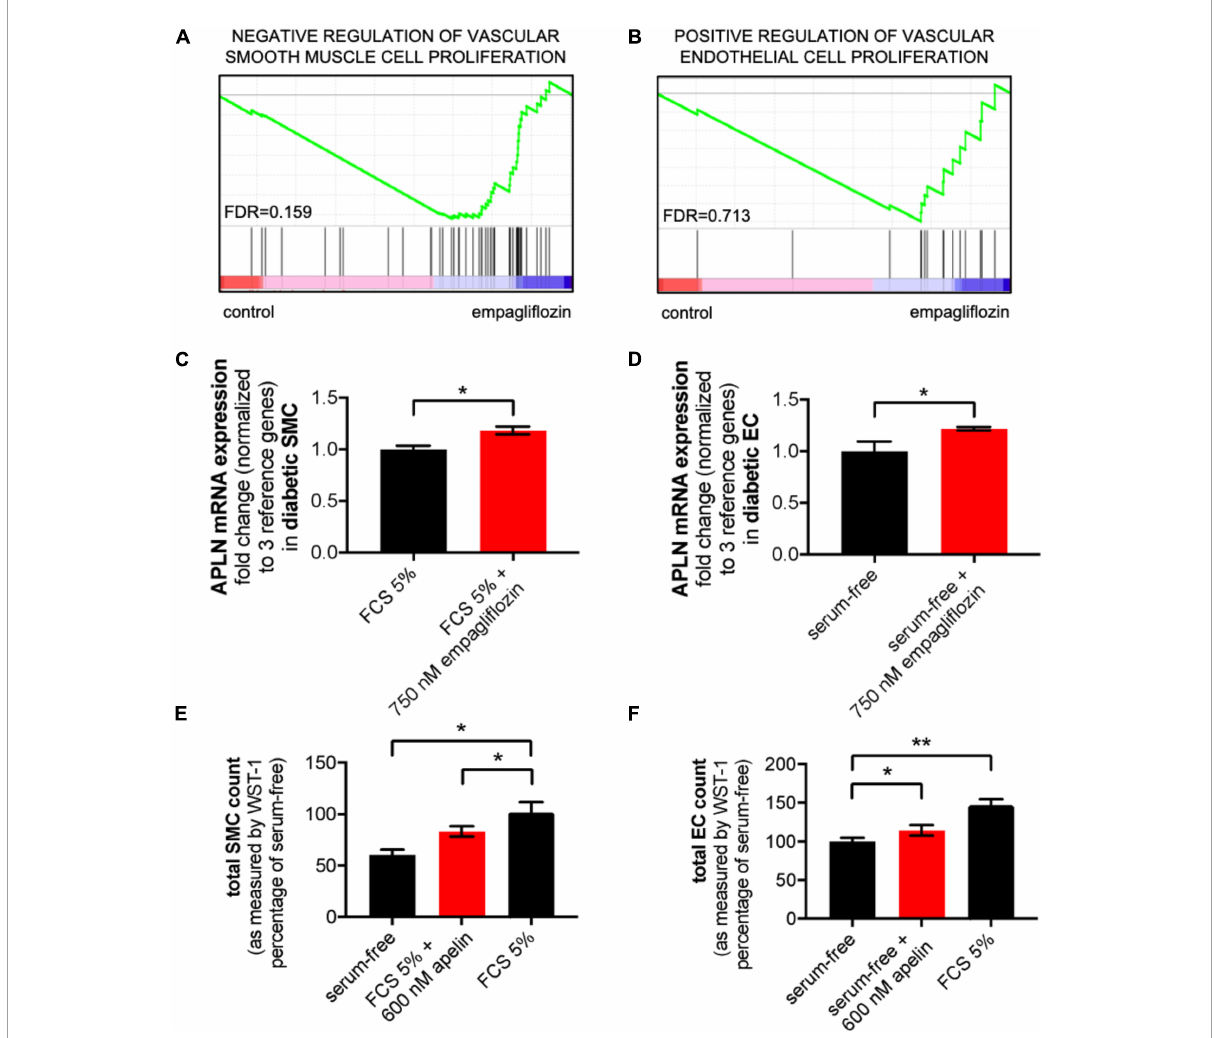
FIGURE4 Apelin is upregulated by empagliflozin, prevents smooth muscle cell (SMC) proliferation and augments endothelial cell (EC) proliferation. (A,B) Two out of 20 most regulated gene sets from RNA-sequencing data of human diabetic coronary artery SMCs ( n = 3). (C,D) Apelin mRNA expression as assessed by qRT-PCR in diabetic SMCs incubated with 5% fetal calf serum (FCS) with and without 750 nM empagliflozin ( C , n = 3, * P < 0.05) and in diabetic ECs incubated with serum-free medium with and without 750 nM empagliflozin ( D , n = 3, * P < 0.05). (E,F) Total cell count assessment of diabetic SMCs (E) stimulated with 5% FCS with or without 600 nM recombinant apelin and ECs with serum-free medium with or without 600 nM recombinant apelin (F) assessed by WST-1 cleavage to formazan at 24 h ( n = 3, * P < 0.05, ** P < 0.01).